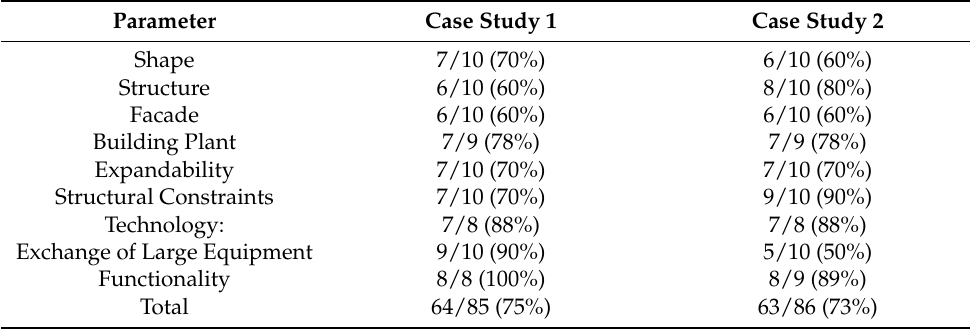
Table 9. Detail of OFAT application on Case Study 1 and Case Study 2.